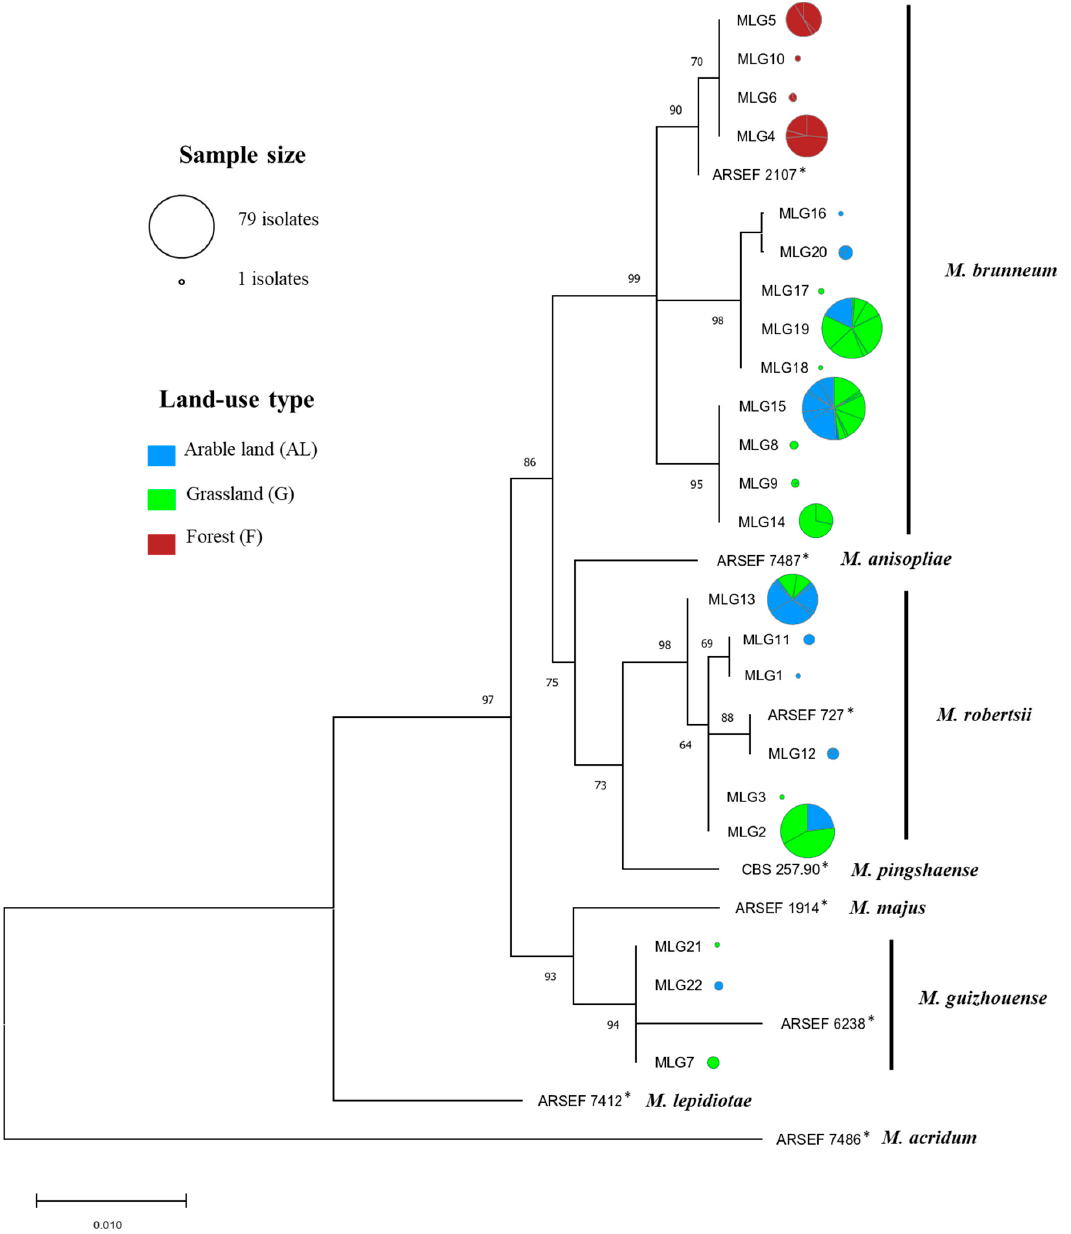
Figure 3. Maximum likelihood phylogenetic tree based on the alignment of 5 ′ -TEF-1 α sequences representing each of the 22 different multilocus genotypes (MLG). Bootstrap values > 60%, calculated with 1000 replicates, are shown. The bar scale indicates 0.01 changes per nucleotide. Each circle represents a unique MLG, and circle size indicates the number of isolates recovered. Colors within the circles represent the fraction of clones obtained per land-use type, and vertex size represents the fraction of clones isolated at sites where the MLG was